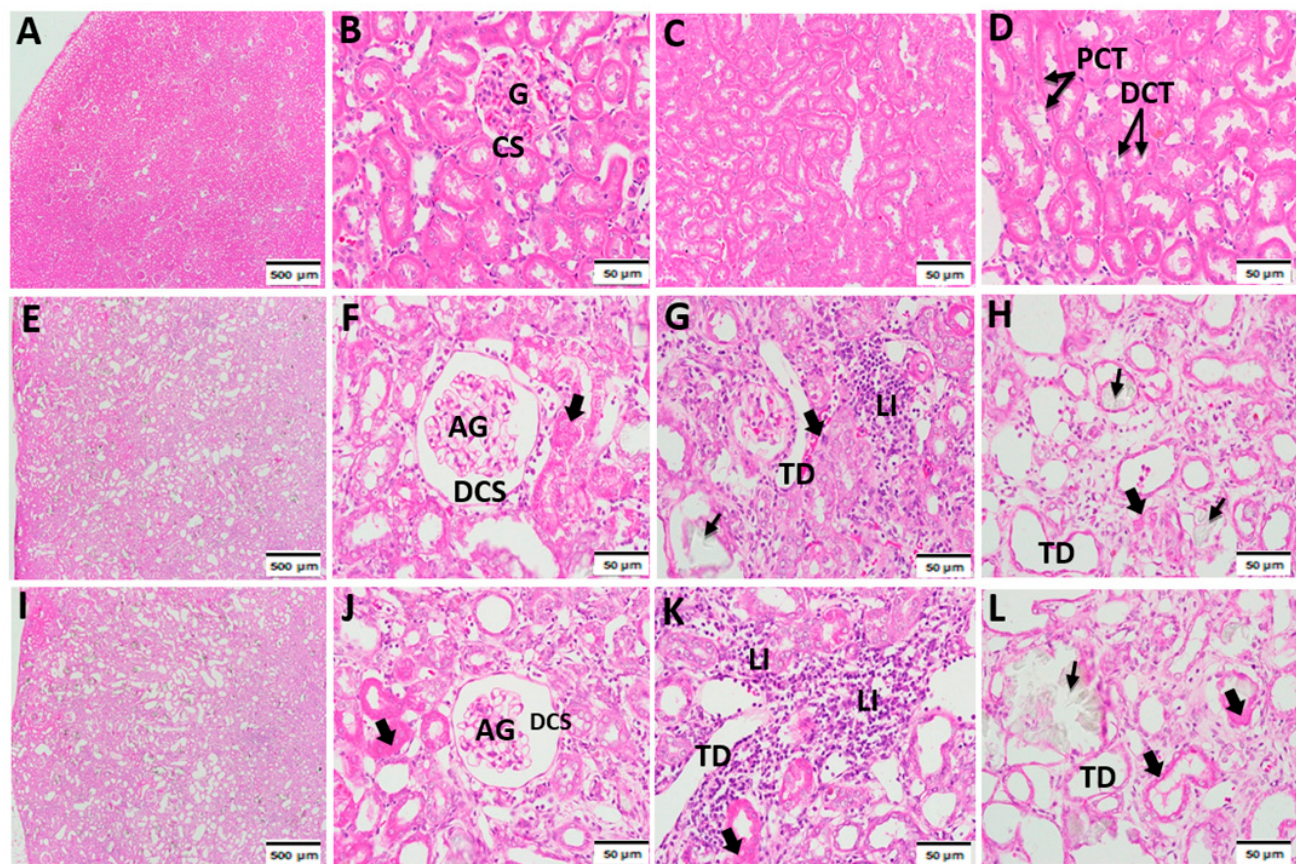
Figure 1. Effects of prenatal acephate exposure on renal histology in adult rat offspring ( n = 8/group). Kidney sections from the treated groups were stained using hematoxylin and eosin reagents (G × 200). Photomicrographs of the kidneys of the control ( A – D ), low ‐ dose acephate ( E – H ), and high ‐ dose acephate ( I – L ) groups. The control group demonstrated a normal renal cortex structure, with normal glomeruli (G), capsule space (CS), and distal (DCT) and proximal tubules (PCTs). The acephate ‐ treated groups (14 and 28 mg/kg) demonstrated tubular dilatation (TD), calcification (arrow), renal cell fibrosis (large arrow), excessive leukocyte infiltration (LI), and atrophy of glomeruli (AG) with dilatation of CS (DCS).